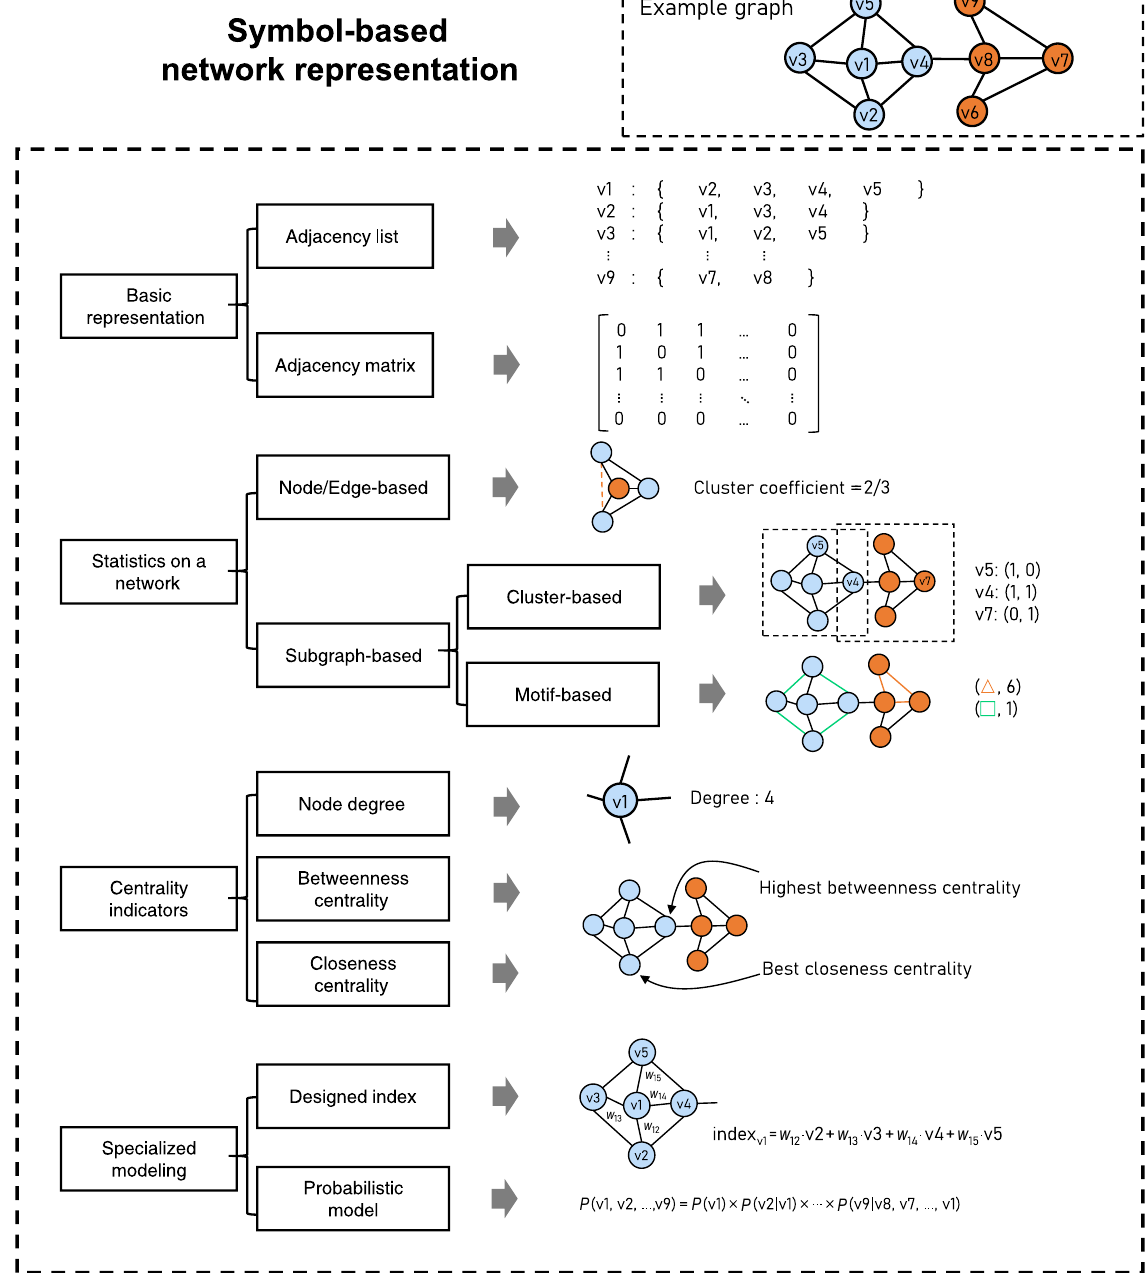
Fig. 5 An illustration of symbol-based network